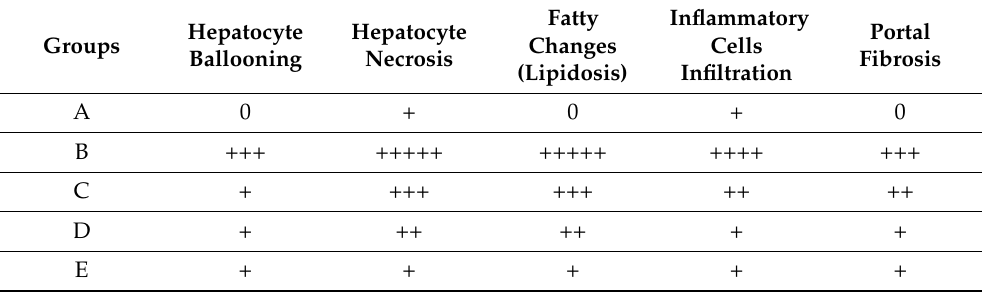
Figure 3. Effect of TA extract on the microscopic analysis of hepatic tissue sections of animals initially treated with CCl 4 . Hematoxylin and eosin stain of hepatic tissues in control (Group A), CCl 4 -treated animals (Group B), CCl 4 +30 mg/kg b.w. TA extract-treated animals (Group C), CCl 4 + 40 mg/kg b.w. TA extract-treated animals (Group D), and CCl 4 + 50 mg/kg b.w. TA extract-treated animals (Group E). Masson’s trichrome staining in control (Group A), CCl 4 -treated animals (Group B), CCl 4 + 30 mg/kg b.w. TA extract-treated animals (Group C), 40 mg/kg b.w. TA extract-treated animals (Group D), and CCl 4 + 50 mg/kg b.w. TA extract-treated animals (Group E). Bar scale = 25 µ m. Magnification × 100. Table 6. Histopathological changes and grading of micro-sections of the